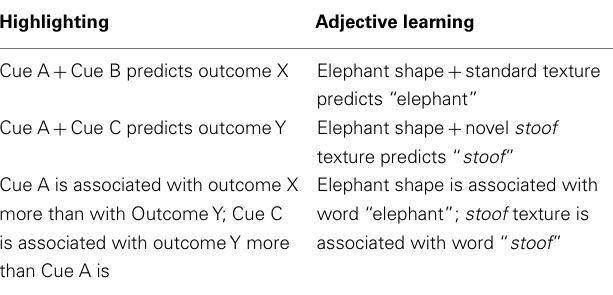
Table 2 | Parallel structure of highlighting and adjective